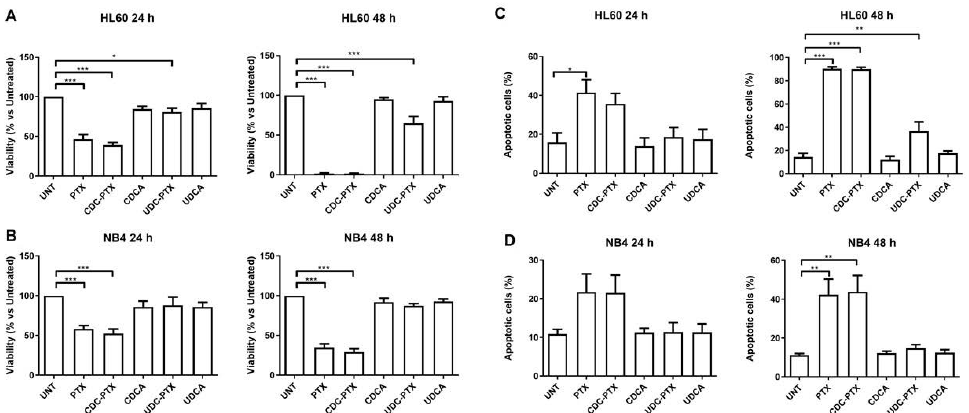
Figure 2. Cell viability and apoptosis evaluation in HL60 ( A , C ) or NB4 ( B , D ) cells treated for 24 or 48 h with 2 µ M of each of the following compounds: PTX; CDC-PTX, CDCA, UDC-PTX or UDCA. Data are reported as mean ± SEM of at least 3-independent experiments. Statistical analysis was performed by ANOVA followed by Bonferroni post hoc test for pairwise comparisons. * p < 0.05; ** p < 0.01 or *** p < 0.001.